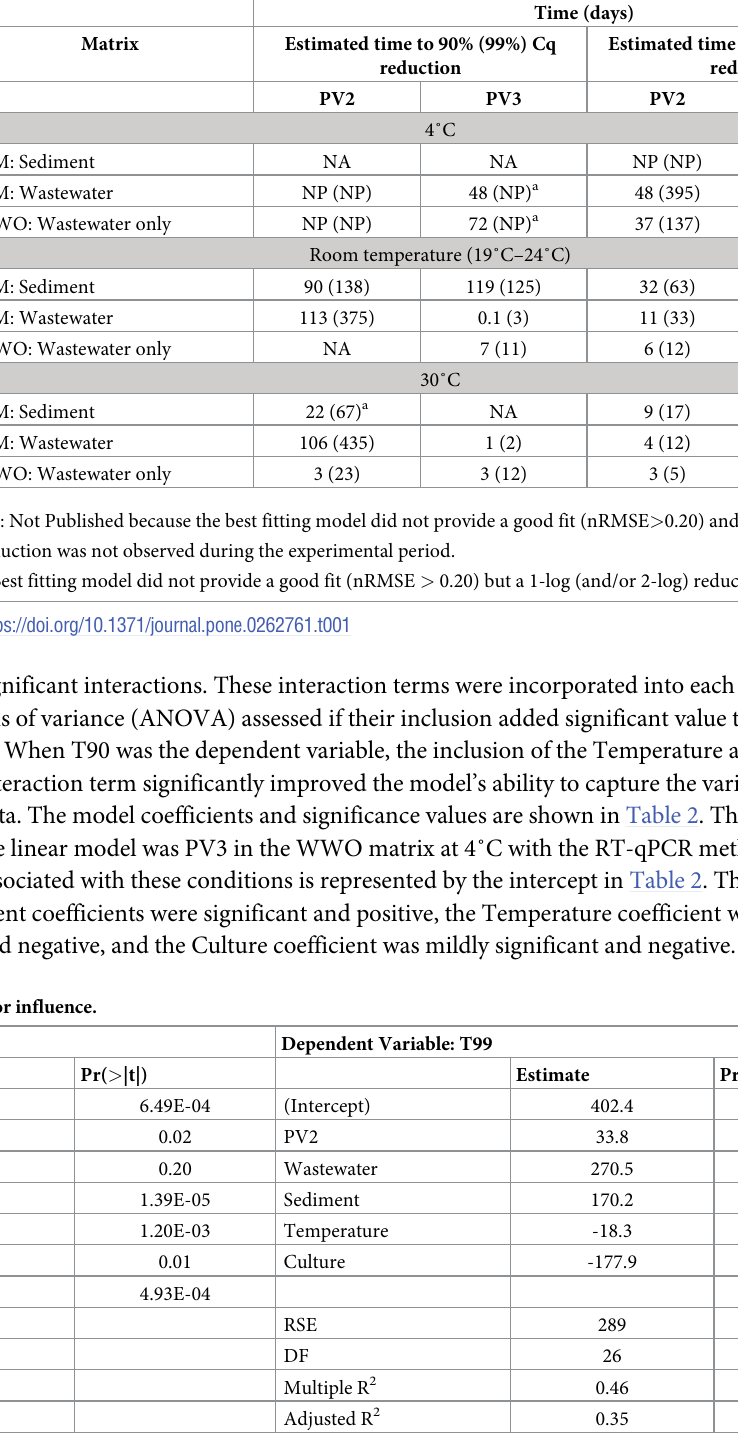
Table 1. Predicted T90 and T99 values for PV2 and PV3 reduction in waste-impacted microcosms.